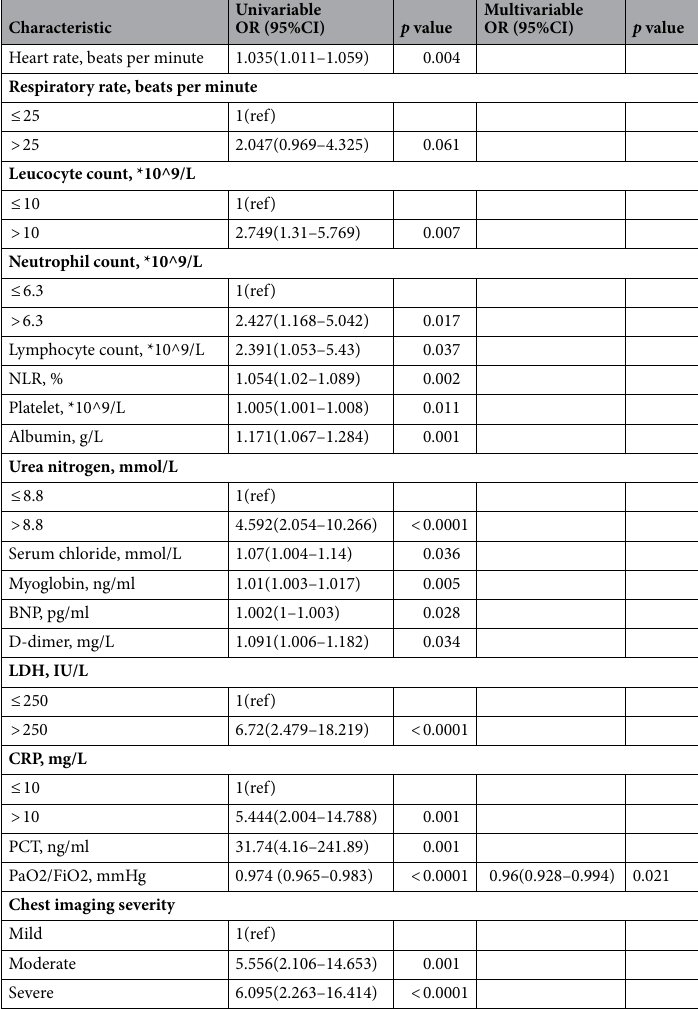
Table 2. Risk factors associated with mortality for intensive care COVID-19 patients. NLR, neutrophil– lymphocyte ratio; BNP, brain natriuretic peptide; LDH, lactate dehydrogenase; CRP, C-reactive protein; PCT, procalcitonin; PaO2, arterial partial pressure of oxygen; FiO2, oxygen